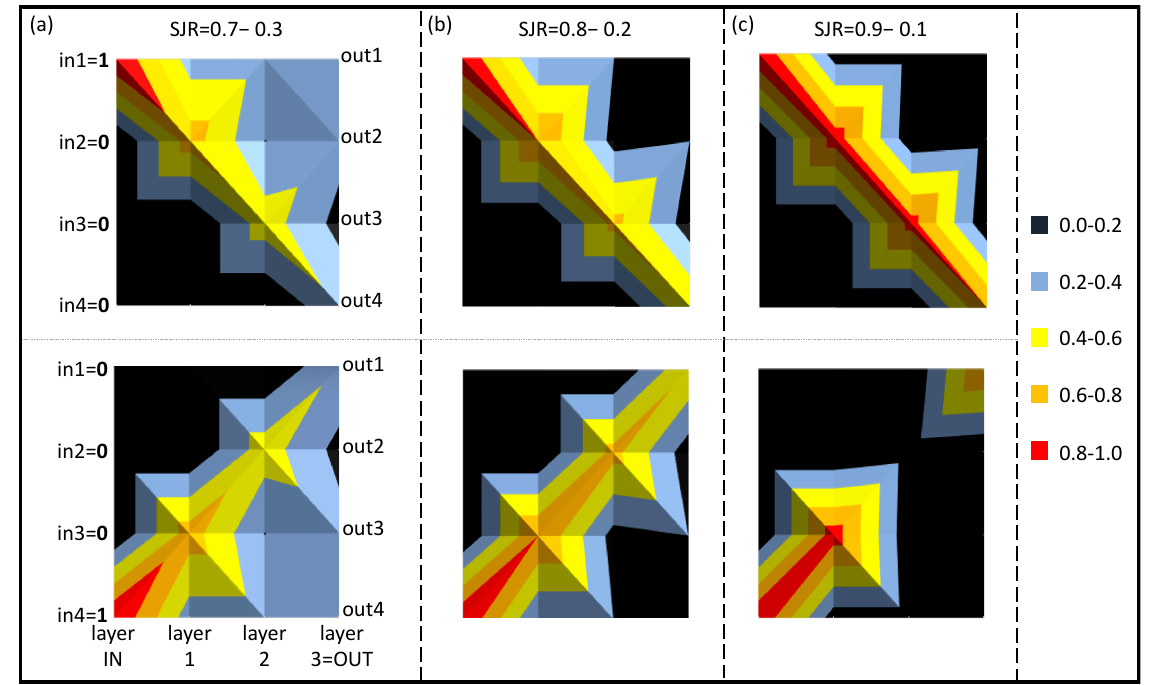
Figure 4. Represents the evolution of the intensities in the three layers with respect to the two input configurations, 1 − 0 − 0 − 0 and 0 − 0 − 0 − 1 (1-digit, 4-bit numbers), for the three cases of SJR: ( a ) SJR = 0.7 − 0.3; ( b ) SJR = 0.8 − 0.2; ( c ) SJR = 0.9 − 0.1.